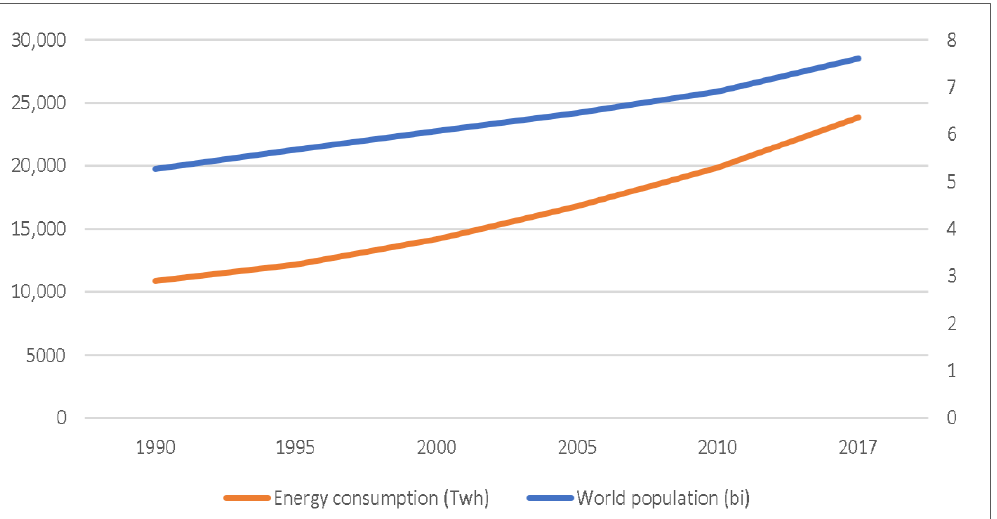
Figure 1. Global population (billion) and energy consumption (TWh) by year (1990–2017), derived from [19].